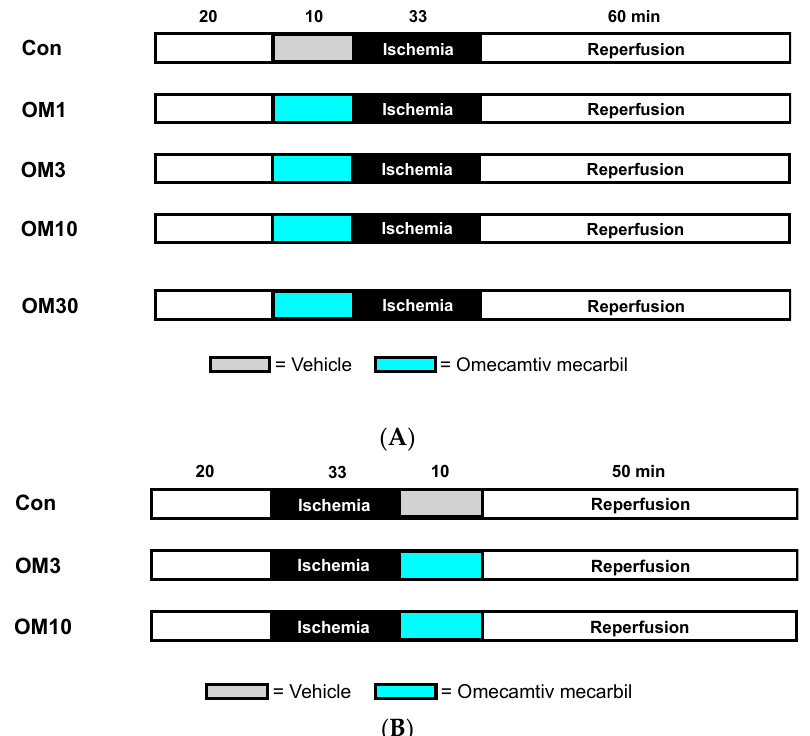
Figure 1. Experimental protocols. ( A ) Investigation of OM preconditioning. Con = control, OM = omecamtiv mecarbil (1–10 µ M). ( B ) Investigation of OM postconditioning. Con = control, OM = omecamtiv mecarbil (3–10 µ M).